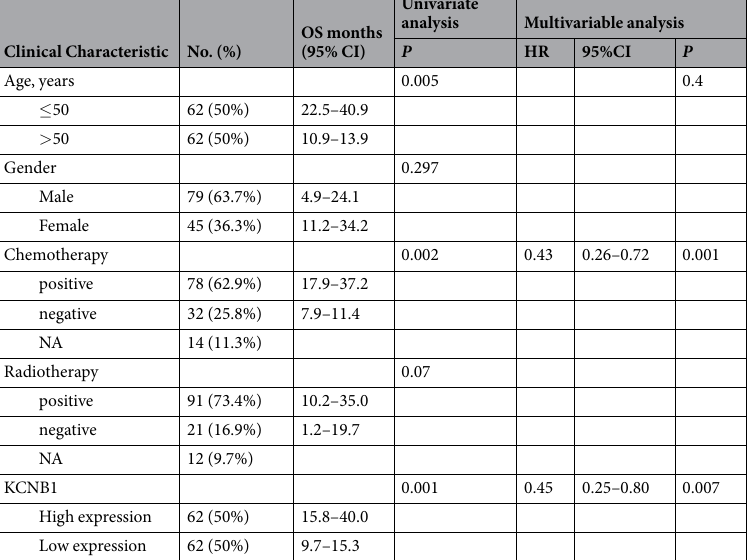
Table 1. Cox proportional hazards regression analyses of KCNB1 expression and other characteristics in relation to overall survival in gliomas from the CGGA cohort.